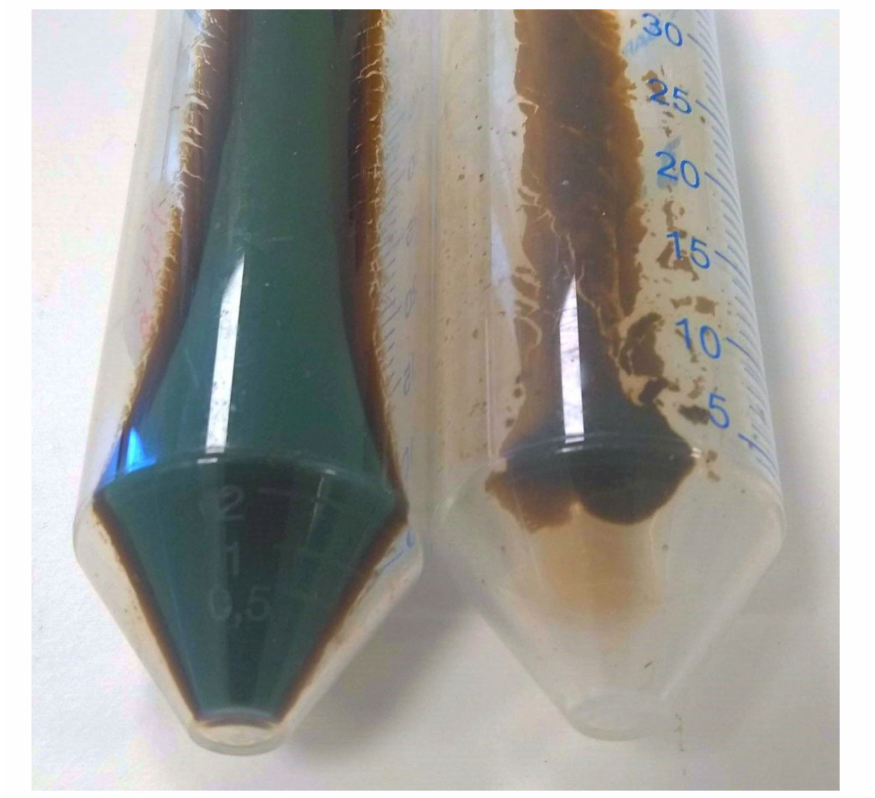
Figure 1. Pellets from centrifugation of complexation solution at 5000 rpm for 2 min. On the left Original_17, on the right, Original_1. Note the blue-greenish precipitate found in the Original_17 pellet, which is not present in the Original_1